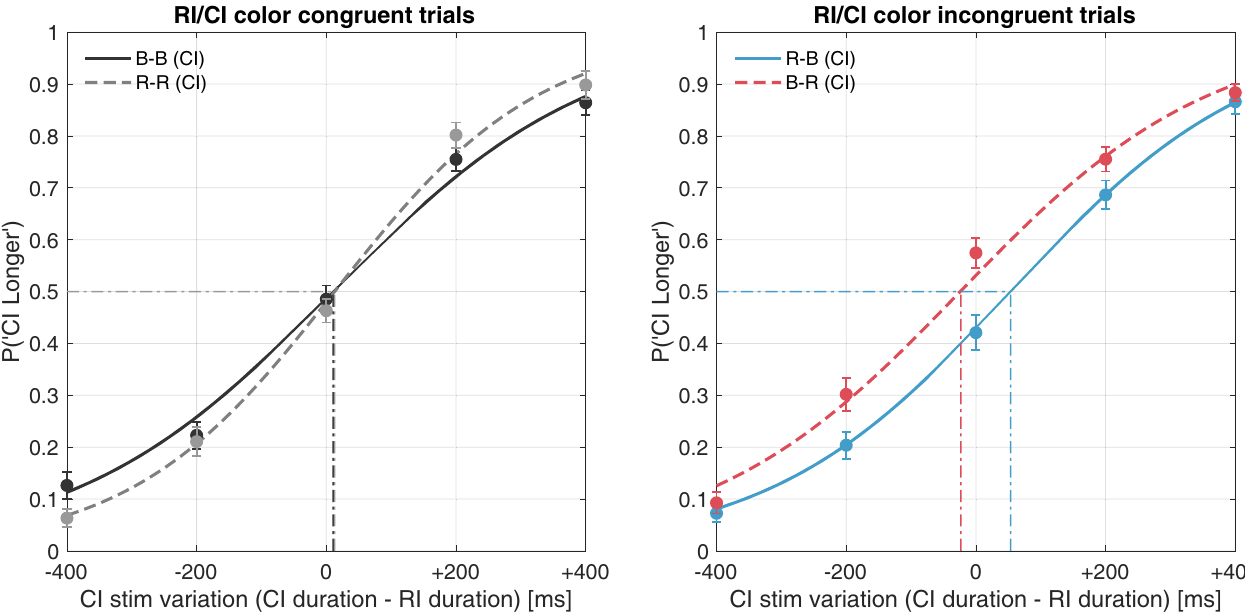
Fig 2. Mean psychometric functions (subjective equiluminance). Left panel: Psychometric function fitting by the proportion of comparison interval–longer (CI) response in congruent color sequence. Right: For an incongruent color sequence. Abbreviations: B–blue, R–red, CI–comparison interval, RI–reference